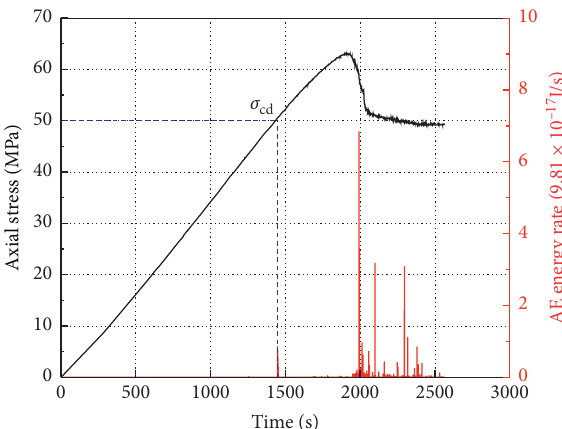
Figure 9: Determination of damage stress point of coal rock by AE method ( _ ε � 10 − 5 s − 1 ).